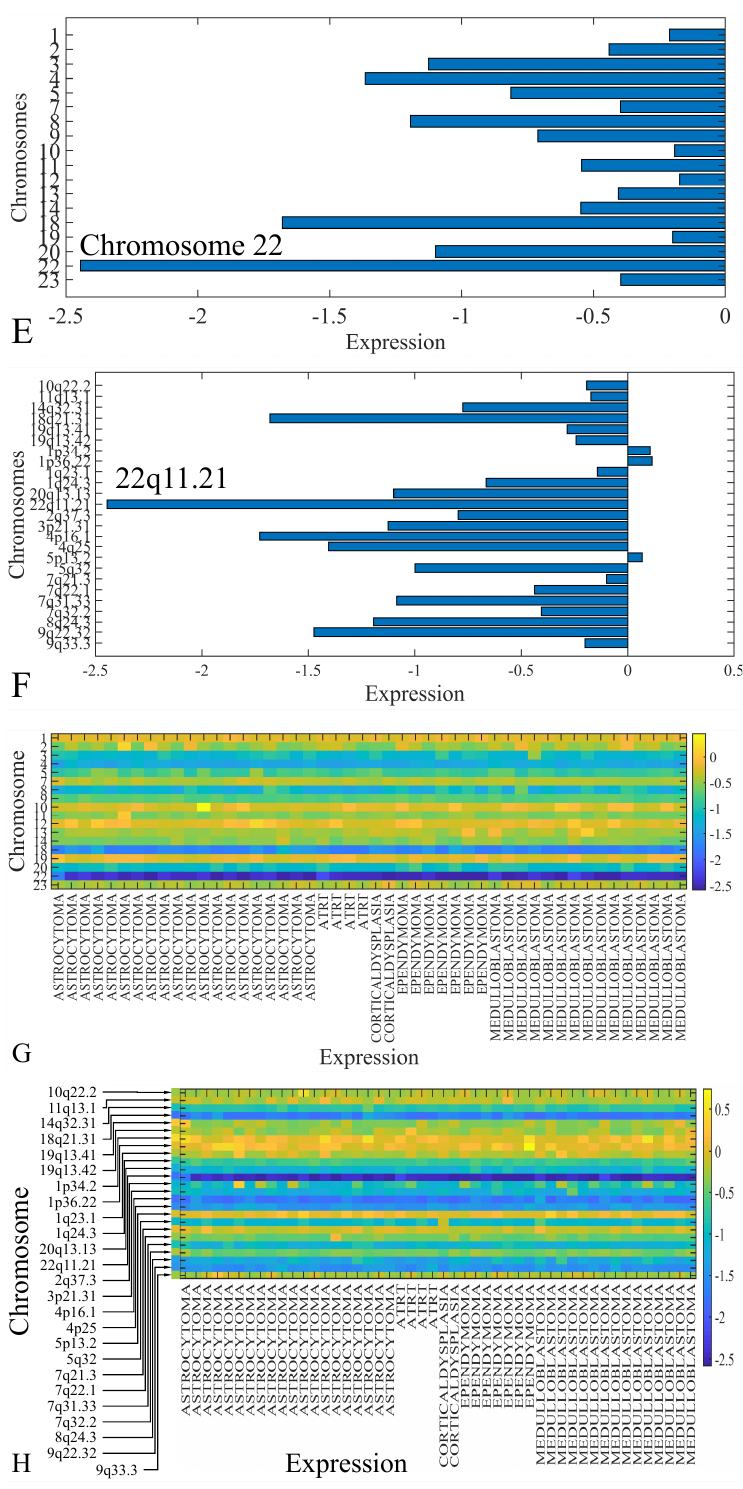
Figure 10. Chromosomal distribution of miRNA expression. miRNA expression, including control samples (“naturals”) was mostly active on chromosome 22 ( A ) and in particular, on the 22q11.21 location ( B ). When investigating the participation of samples, we have found that control samples contributed mostly to the miRNA expression on chromosome 22 ( C ) and location 22q11.21 ( D ). When calculating the miRNA ratios, chromosome 22 ( E ) and location 22q11.21 ( F ) were the most active locations. In the case of miRNA expression ratios, it appeared that all tumor samples contributed equally to chromosome 22 ( G ) and 22q11.21 ( H